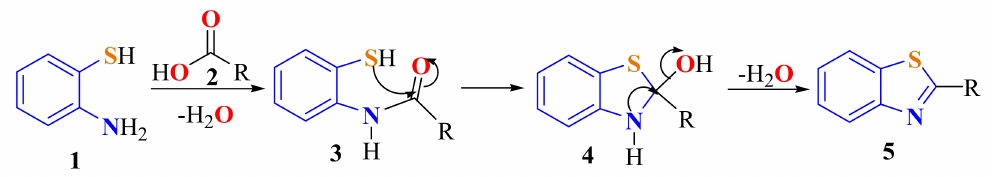
Scheme 1. Mechanistic pathway in the condensation of ATPs with carboxylic